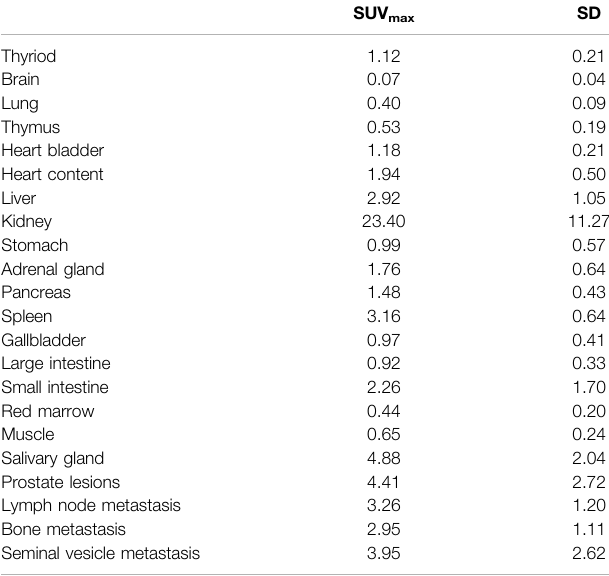
TABLE 4 | Different organs ’ SUV max for 68 Ga-DOTA-DiPSMA in PCa patients. SUV max SD Thyriod 1.12 con fi rmed by needle biopsy. SUV max for prostate lesions, bone metastases, and lymph node metastases were 4.41 ± 2.72, 2.95 ± 1.11, and 3.26 ± 1.20, respectively ( Table 1 ; Figure 4 ). Low background uptake was observed in 68 Ga-DOTA-DiPSMA (the